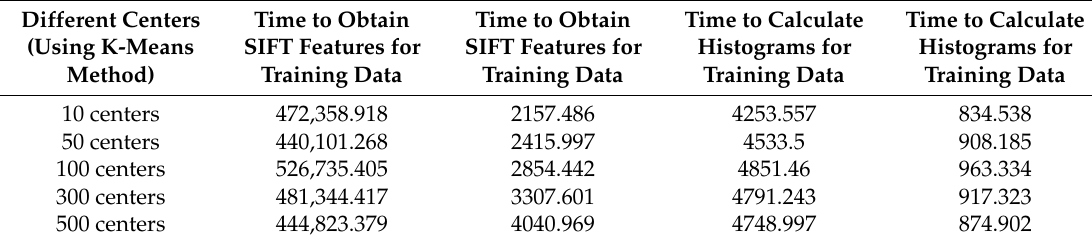
Table 2. Time for BOW with the training and testing data (in seconds).